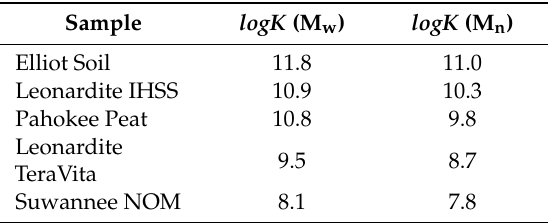
Table 2. Estimated conditional logK for humic substances at pH